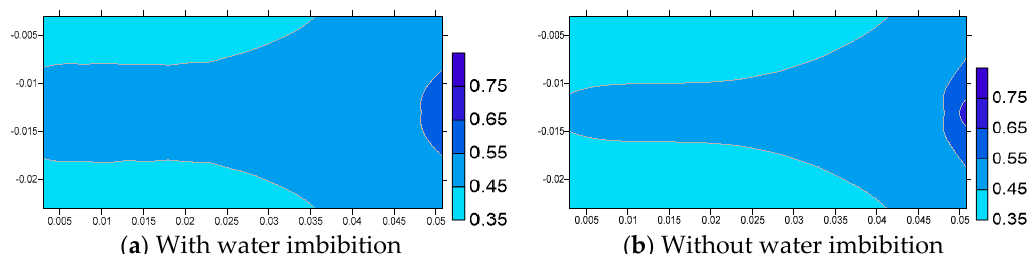
Figure 22. Oil recovery comparison of water huff-‘n-puff with and without imbibition (Case-4).